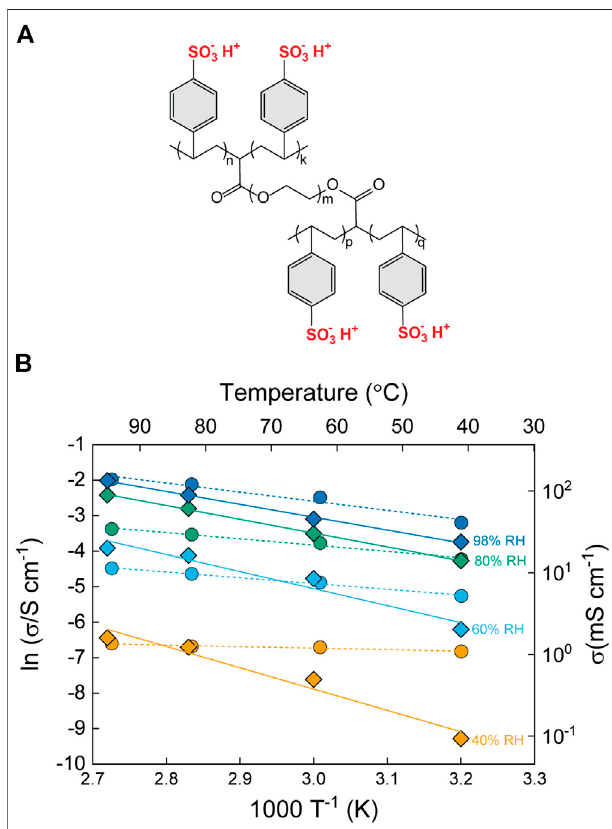
FIGURE 9 | (A) The chemical structure of polystyrene sulfonate crosslinked with PEGDA, which was used to prepare a composite membrane withbacterialnanocellulose. (B) Arrheniusplotofthein-planeconductivityofa Na fi on ® /BC (1:1) composite membrane for different relative humidities (circular data points), and of a crosslinked PSS/BC composite membrane ( ∼ 17 wt% BC) (diamond data points). The results show typical ionomer-like behavior, with a strong dependence on humidity and weaker dependence on temperature. Redrawn from Gadim et al. (2014). Gadim et al. (2016).